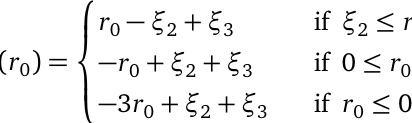
singularity and its vertical reduction. By flopping C 1